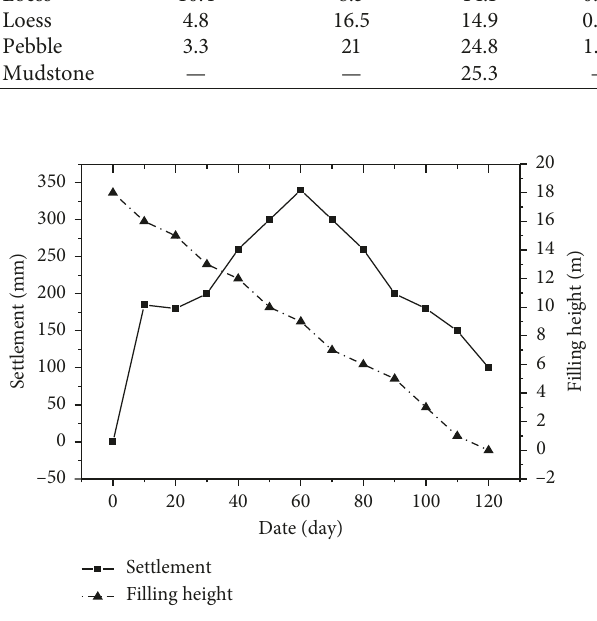
Figure 6: Relationship between filling height and settlement of the filling during construction.